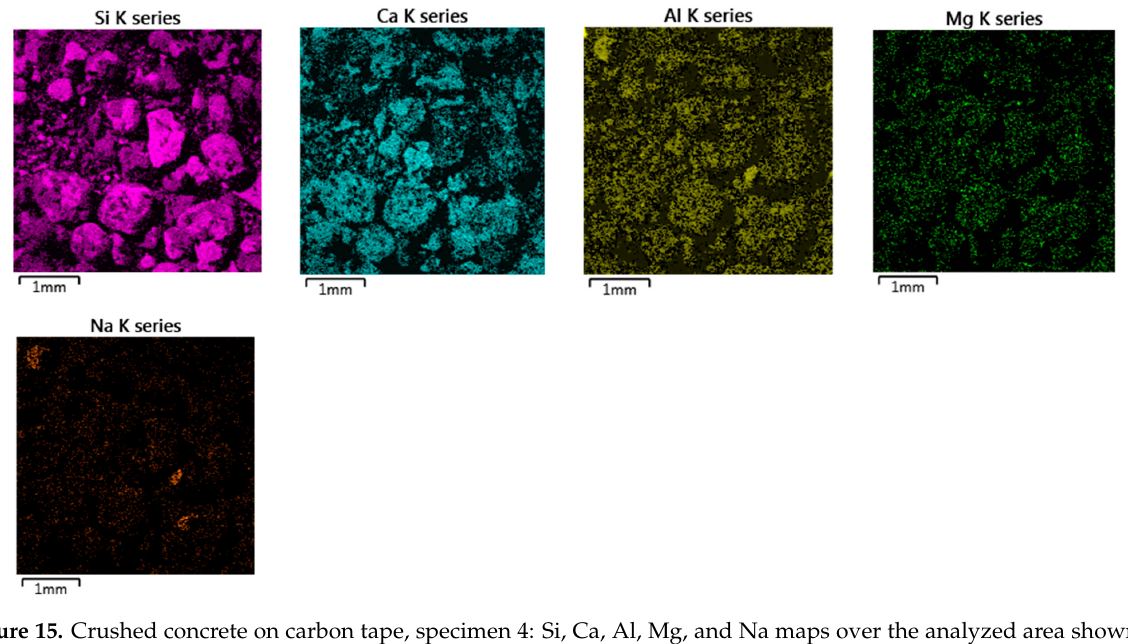
Figure 15. Crushed concrete on carbon tape, specimen 4: Si, Ca, Al, Mg, and Na maps over the analyzed area shown in Figure 14b. Mg is evenly distributed throughout the image, suggesting it is absorbed freely.